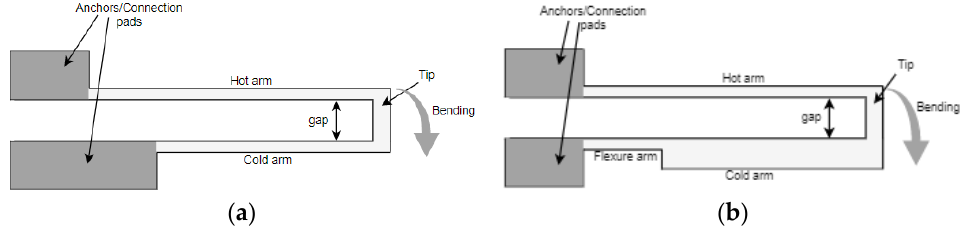
Figure 7. Electrothermal MEMS actuators with: ( a ) different arm lengths; ( b ) different cross section.